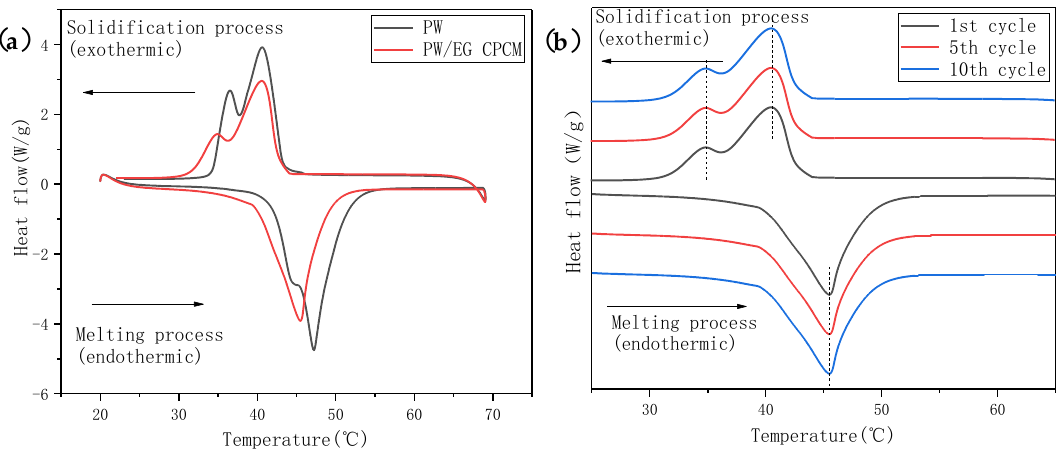
Figure 13. DSC spectrum. ( a ) DSC curves of PW and CPCM. ( b ) Cyclic DSC test curve of PW/EG CPCM.